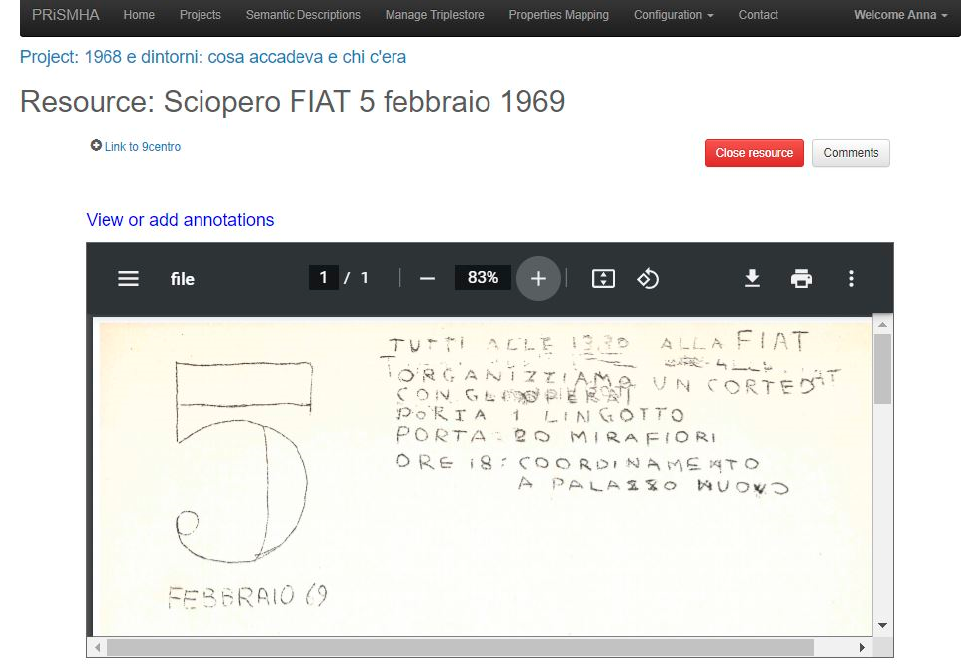
Figure 2. The page for annotating a document on the PRiSMHA prototype platform.